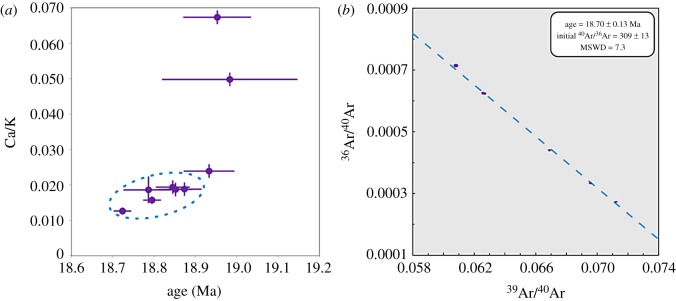
Ca/K versus age correlation diagram and isochron. (a) Ca/K versus age correlation diagram of the CHILC-AT1 biotite separate obtained by 40Ar/39Ar analyses. The dashed ellipse includes the isochemical heating steps 4–9 considered for the age calculations. Step 9 is the one with the lowest Ca/K ratio and the youngest age. Other steps with a high Ca/K ratio have been considered as a result of alteration and not taken into account in the age calculation. All uncertainties are given as 2σ. (b) Isochron of the CHILC-AT1 biotite crystals, considering only the isochemical heating steps 4–9. The age obtained is 18.70 ± 0.13 Ma, with an MSWD of 7.3. The sizes of the ellipses representing points are the 2σ uncertainties.